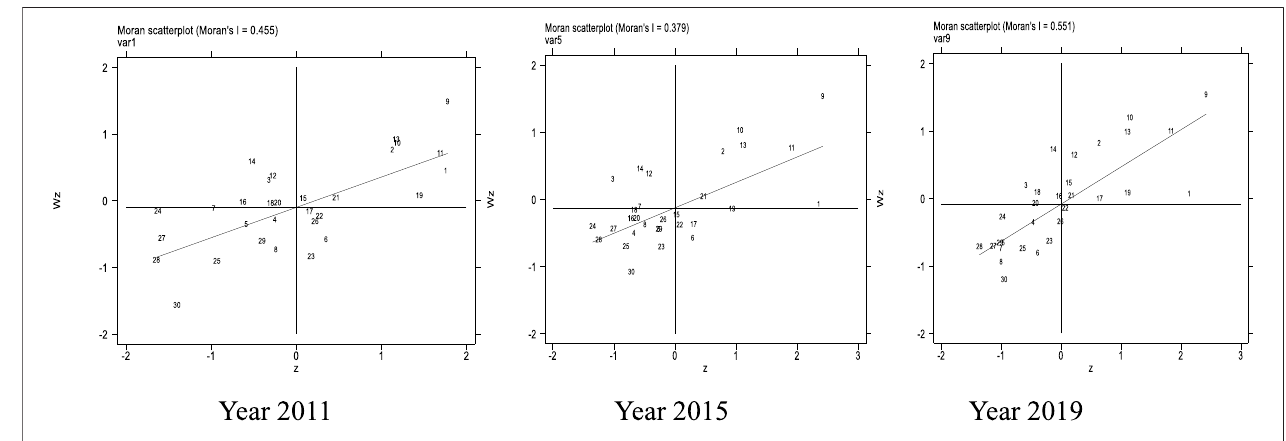
FIGURE 4 | Scatter plot of the Moran ’ s I of China ’ s digital fi nance in 2011, 2015, and 2019.